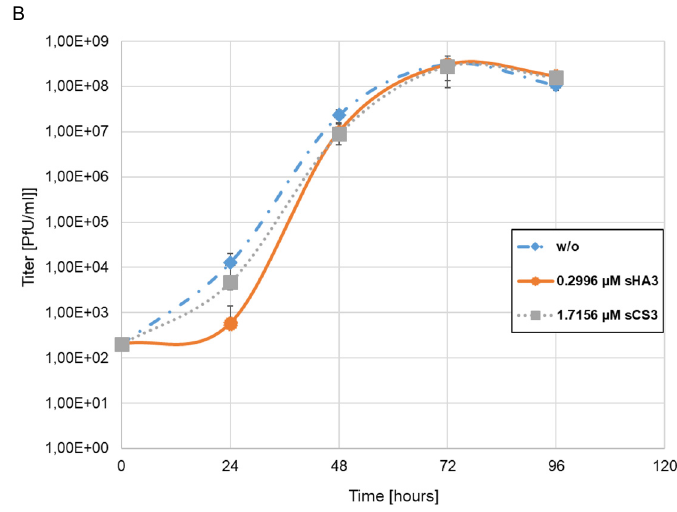
Figure 3. Growth curves in the presence of high-sulfated GAGs. ( A ) Diagram of the experimental settings. ( B ) PT cells were infected with BCoV (MOI 0.00005) in the absence ( w / o ) or presence of 0.2996 µM sHA3 or 1.7156 µM sCS3. At each time point, supernatants were harvested and titers determined on PT cells. Given are mean values and corresponding SD of three independent experiments.